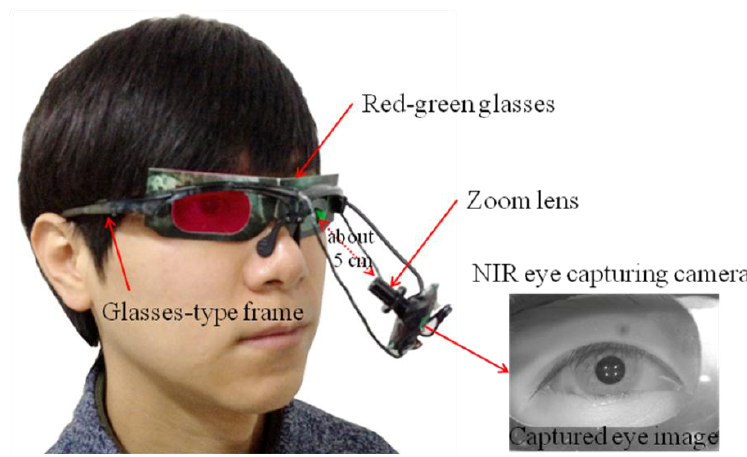
Figure 1. Eye capturing device and captured eye